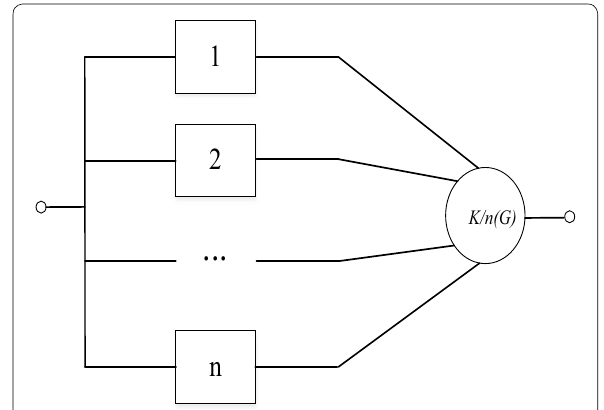
Fig. 1 Reliability block diagram of k / n ( G )